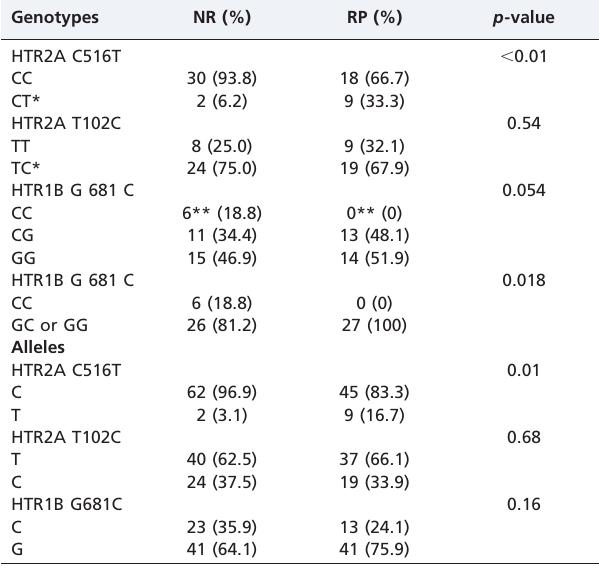
Table 2 - Polymorphism frequency among non- responders and